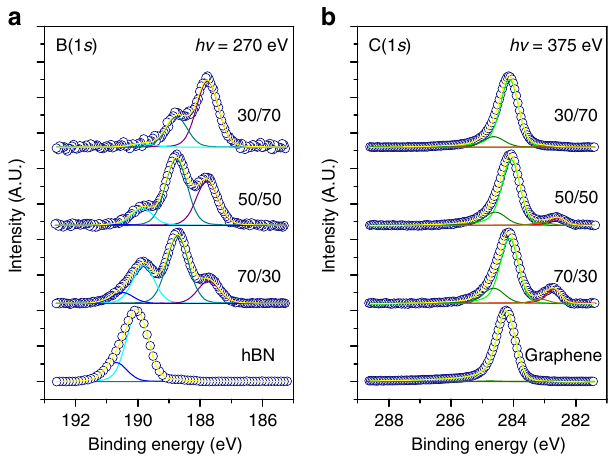
Fig. 5 In situ XPS experiments. a B(1 s ) core level taken with incident photon energy of 270 eV. b C(1 s ) taken with incident photon energy of 375 eV. The n/m ratios refer to the partial pressure ratios of borazine, n , and ethylene, m , used during growth. Data are plotted on separate arbitrary y -axes and intensities should not be compared between samples. The experimental data are shown as empty circles , while the fi t is in yellow . The B(1 s ) and C(1 s ) spectra have been fi t using four components each. These are labelled B 0 – B 3 and C 1 – C 4 , respectively. In a , the B(1 s ) components have been assigned as follows: B 0 ( blue curve ) and B 1 ( cyan curve ) correspond to hBN, with binding energy difference being ascribed to the B 0 atoms being closer to the Ir(111) substrate. B 2 ( dark green curve ) represents B atoms binding to at least one C atom in the alloy structure and B 3 ( purple curve ) are B atoms binding to either B or C, but no to N atoms. In b , for the C(1 s ) spectra, the C 1 ( green curve ) component corresponds to pristine graphene, and C 2 ( dark green curve ) can be explained by either defects in the graphene or C-N binding motifs. C 3 ( dark yellow curve ) and C 4 ( red curve ) correspond to C atoms in the alloy structure binding to one and two B atoms, respectively. The relative intensities for the components of the B(1 s ) and C(1 s ) peaks for each sample are reported in Supplementary Table 2 and